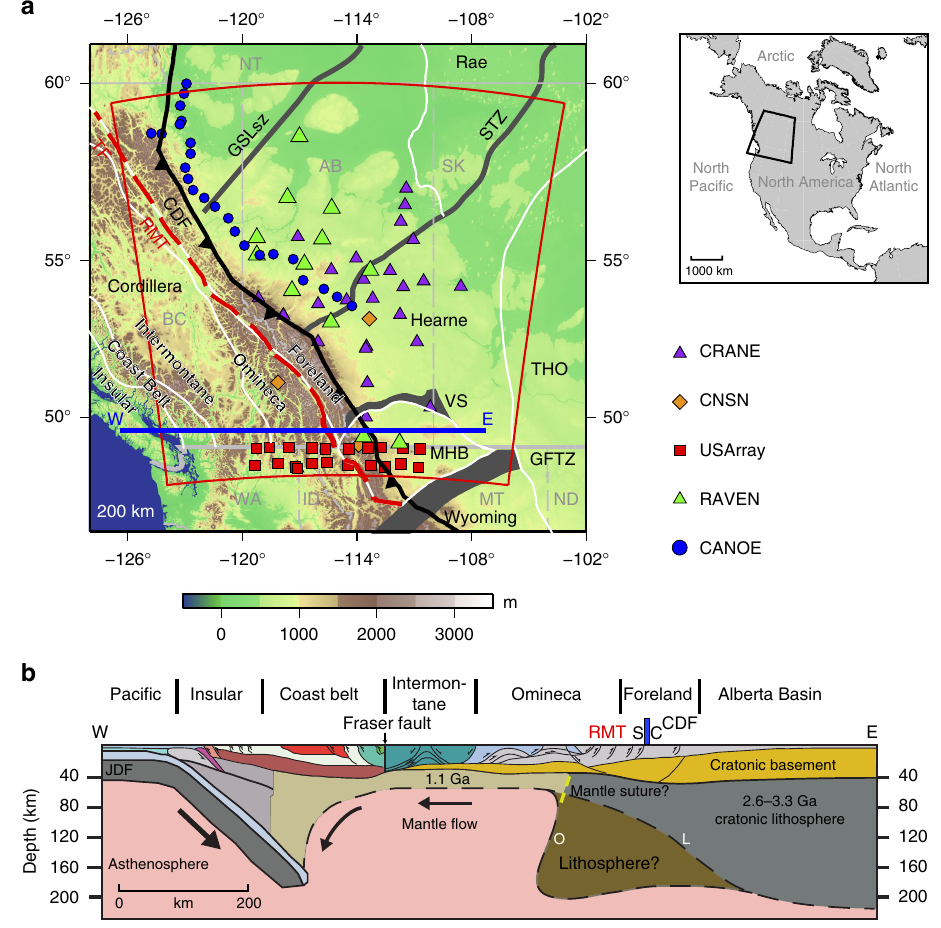
Fig. 1 Tectonic setting of the Cordillera – craton transition region in western Canada. a Topographic relief map superimposed with station coverage. The boundaries of the tomographic model are denoted by the red polygon. Seismic stations are shown by various symbols. The thick gray lines represent the important structural discontinuities within the craton and the white lines indicate the major domain boundaries in southwestern Canada 19,20 . The black barbed and red dashed lines mark the location of the Cordilleran Deformation Front (CDF) and the Rocky Mountain Trench (RMT)-Tintina Fault (TF) system, respectively. The map area relative to North America is shown by the enclosed region in the regional map to the right. b A schematic cross-section showing the structural transition from the Cordillera to craton (location indicated by the blue line on the map). The blue bar marks the carbonate (C) to shale (S) facies boundary, the proposed Cordillera – craton surface suture. The thin dashed lines mark the interpreted lithosphere-asthenosphere boundary (LAB), with either a landward (L) or oceanward (O) dip inferred for accretionary and collisional models, respectively. Modi fi ed after ref. 21 . GFTZ, Great Falls Tectonic Zone; GSLsz, Great Slave Lake shear zone; MHB, Medicine Hat Block; STZ, Snowbird Tectonic Zone; THO, Trans-Hudson Orogen;